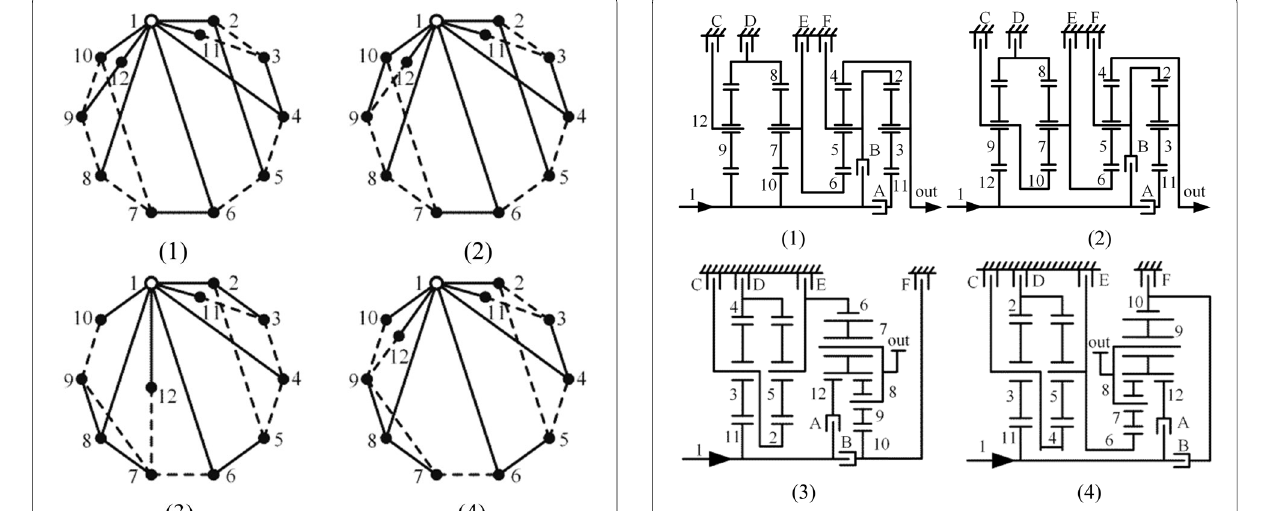
Figure 8 The structure diagrams of AT mechanisms converted from DBGs presented in Figure 6